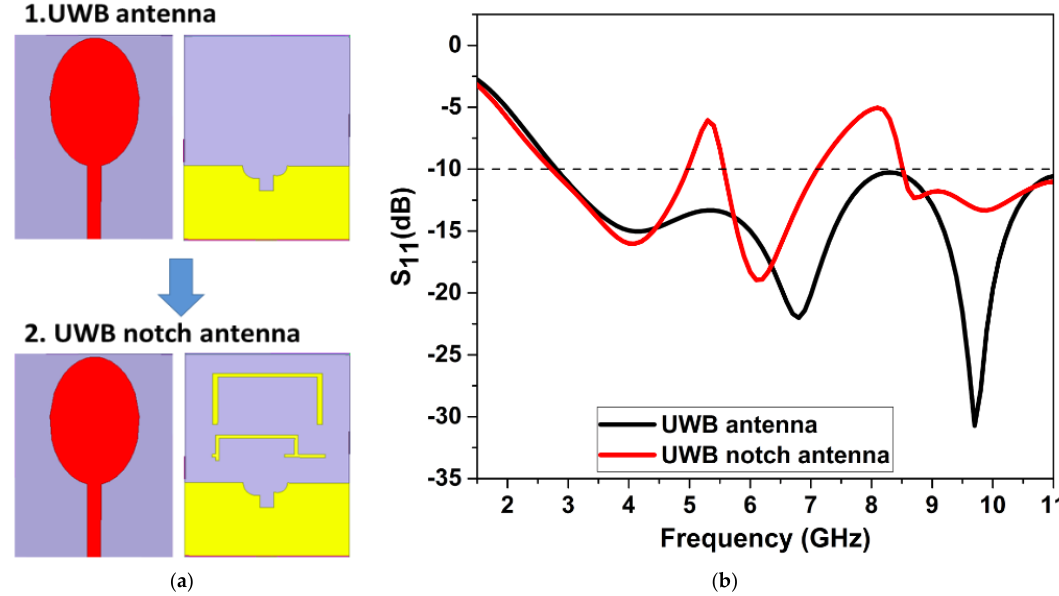
Appl. Sci. 2023 , 13 , 1310 Figure 3. Elliptical UWB notch antenna: ( a ) UWB to UWB notch; ( b ) S 11 . Figure 3. Elliptical UWB notch antenna: ( a ) UWB to UWB notch; ( b ) S 11 .